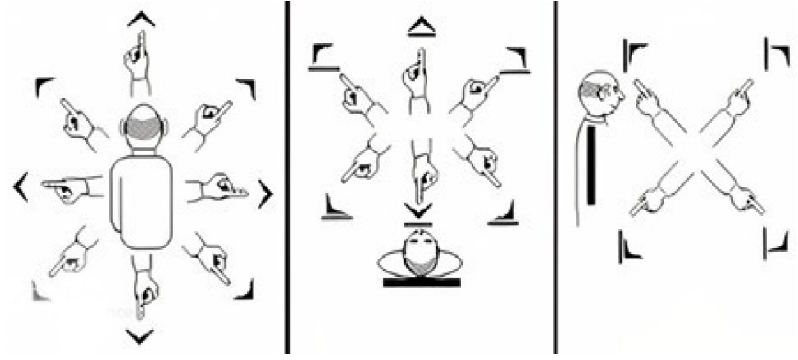
Figure 2. Various Directions of HamNoSys Pointers. Indian Sign Language consists of gestures as shown in Table 2. Table 2. ISL Directions.